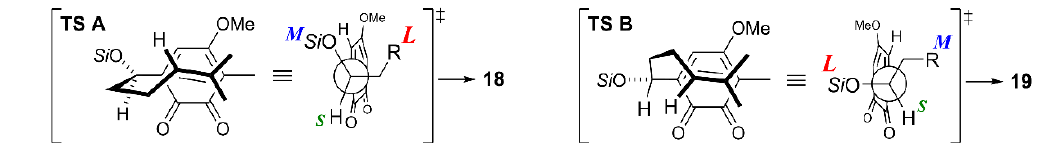
Figure 3. Plausible transition states of the IMDA reaction.